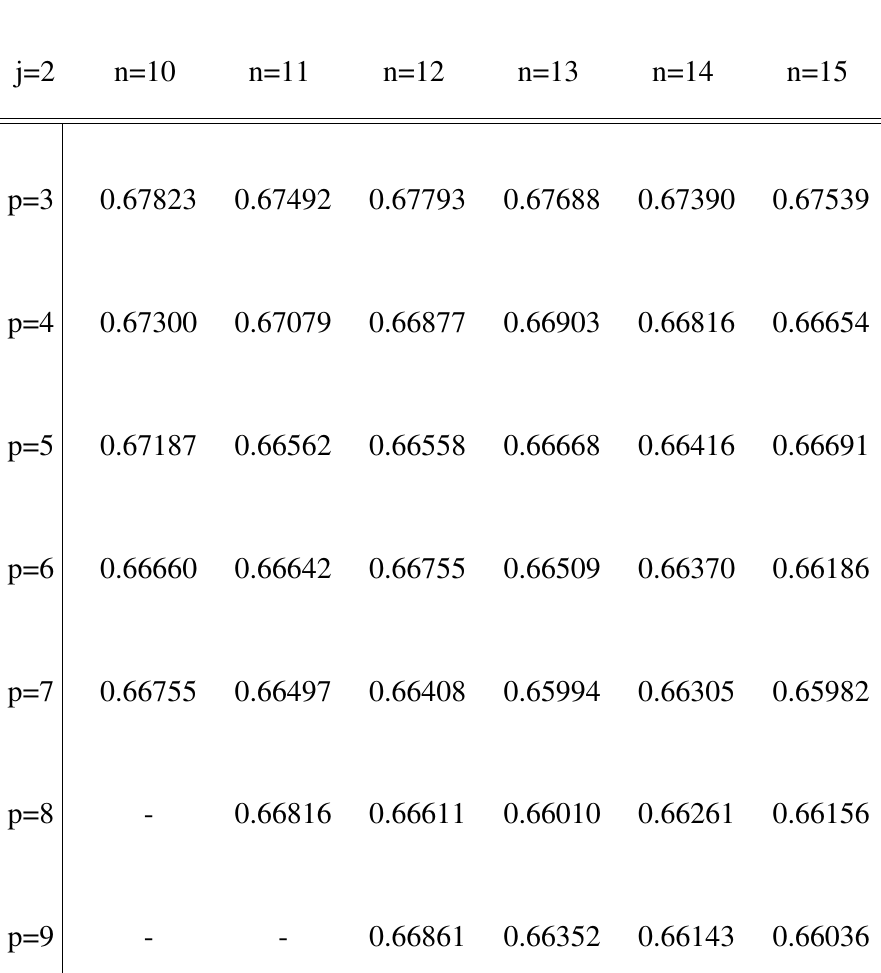
Table 1: Average Value of Dominance for different values of n and p for j = 2 sigma = 1